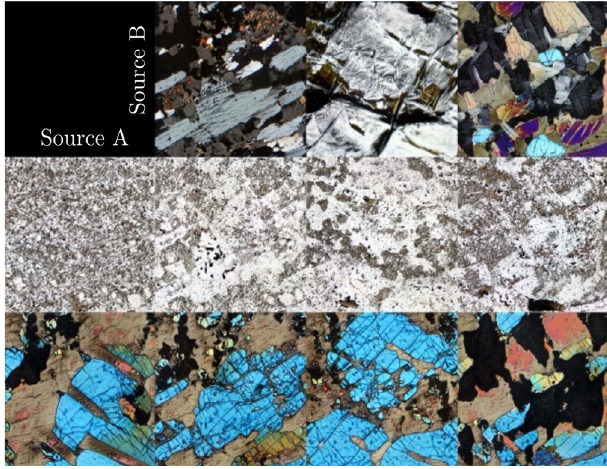
Figure 11. Style-mixing of thin sections from a sample (Source A) to another (Source